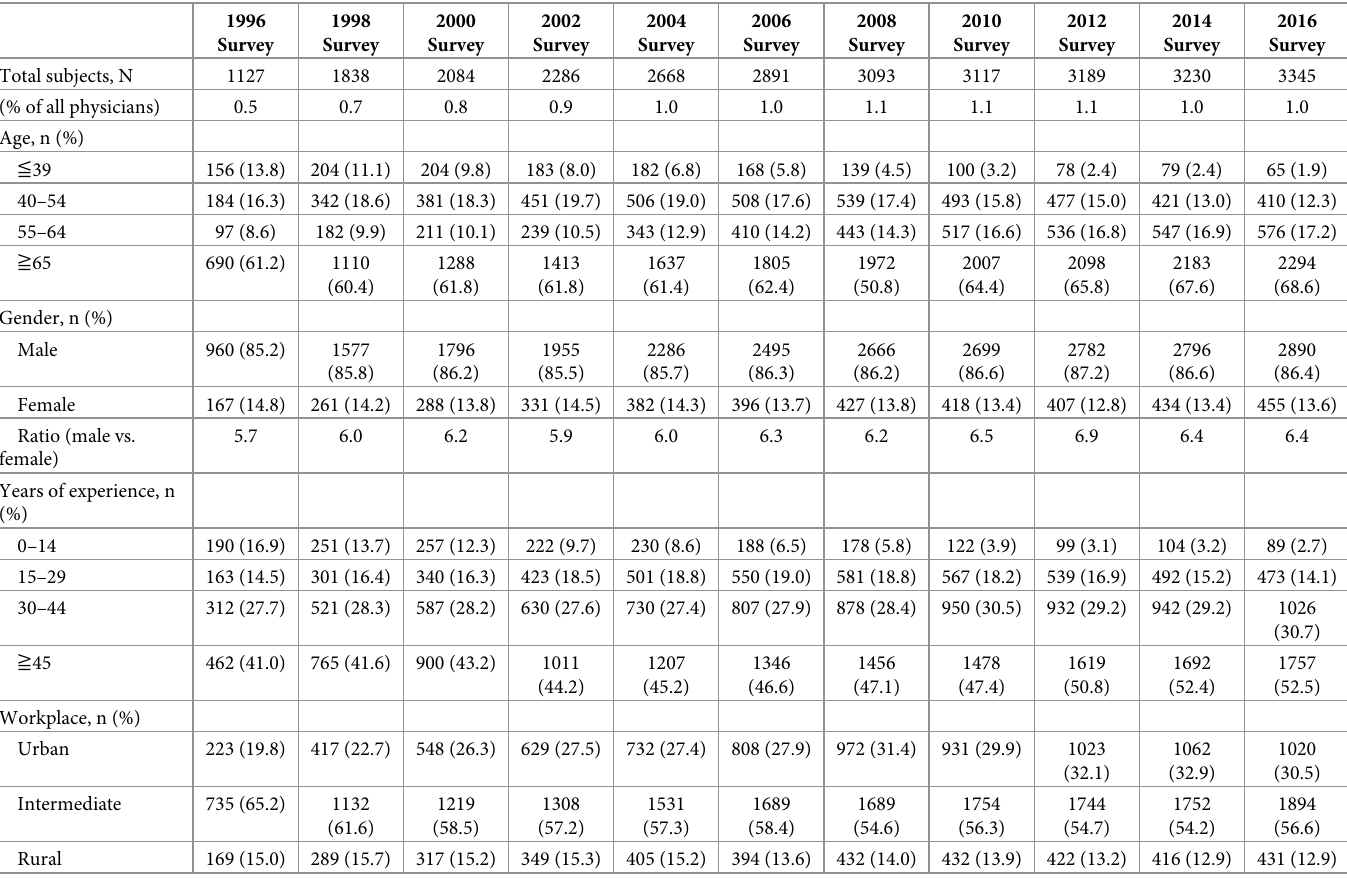
Table 1. Temporal trend in the number, proportion, and characteristics of physicians working at